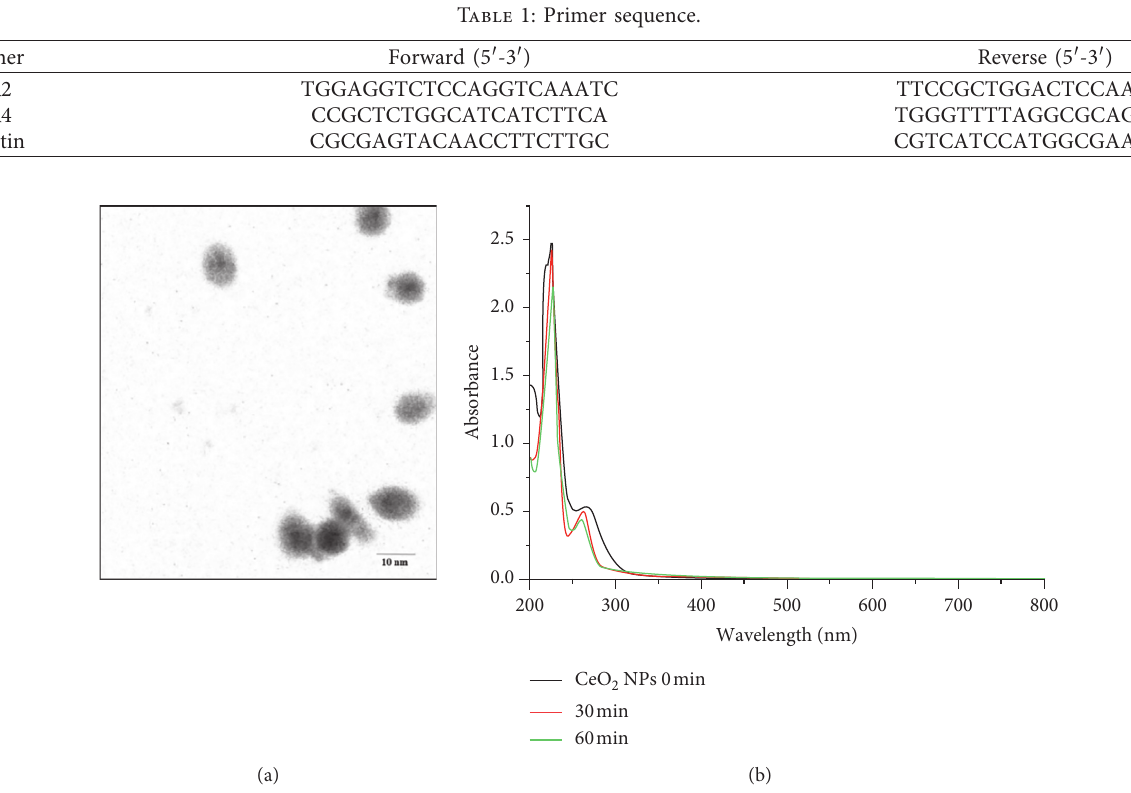
Figure 1: Transmission electron microscopy and UV-visible spectrum analysis of CeO2 nanoparticles.